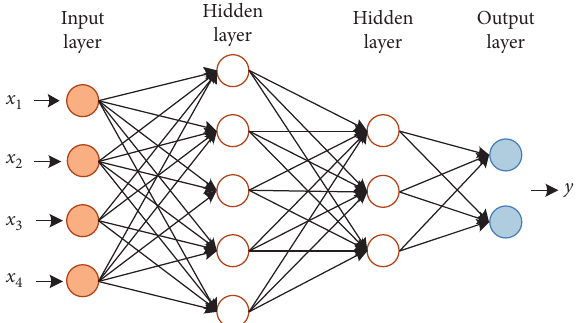
Figure 2: Structure of the neural